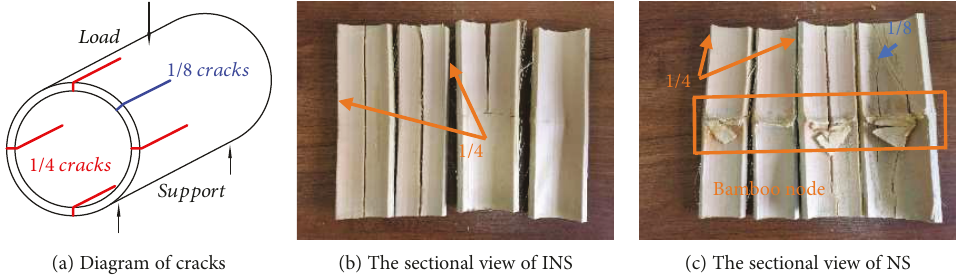
Figure 6: Diagram of cracks and the section view of broken samples with zero, single, and three nodes.